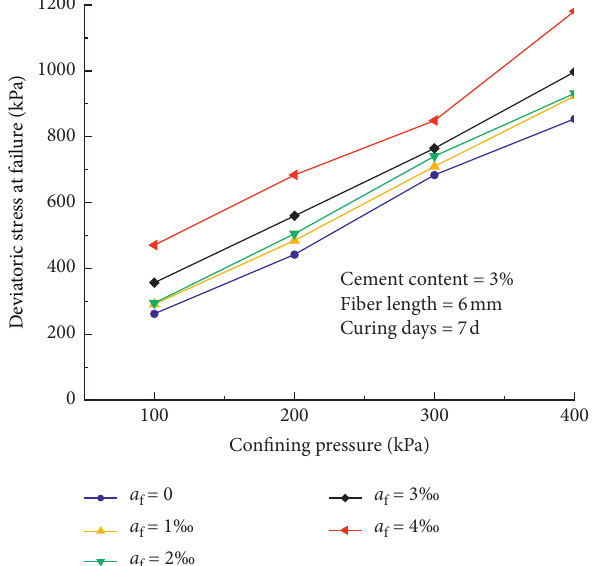
Figure 12: Deviatoric stress at failure under different confining